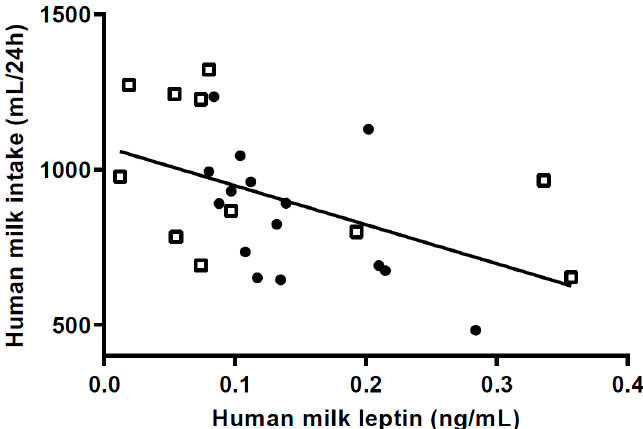
Figure 4. Scatterplot of 24 h milk intake in relation to milk leptin at 5 months ( p = 0.011) ( n = 11 in high weight gain group (HW); n = 15 in normal weight gain group (NW); HW = □ NW = ● Regression for HW group ( p = 0.15); for NW group ( p = 0.031).